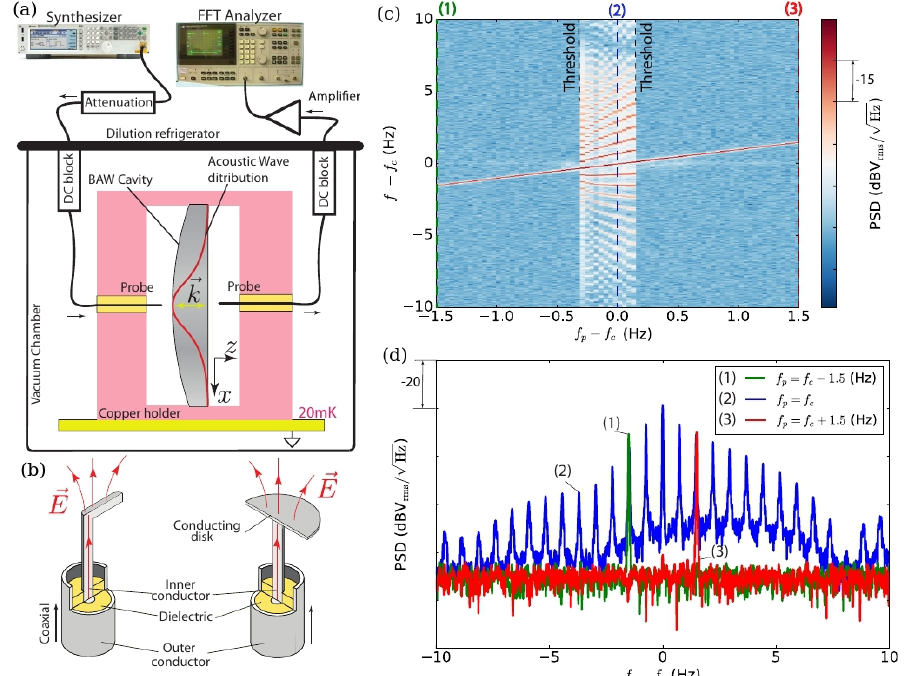
Figure 6. Generation of a BAW-based phononic FC. ( a ) Sketch of the experimental setup showing the BAW resonator, copper holder and excitation probes placed in a vacuum chamber. ( b ) Illustration of two types of excitation probes used in the experiment: L- (left) and disc-shaped (right) antennae. ( c ) A false-colour map composed of the individual output signal PSDs S ( f − f c ) plotted as a function of the pump frequency detuning f p − f c at a constant incident power P = − 66dBm. ( d ) Three PSD curves for different constant incident frequencies f p and the same power P corresponding to slices (1)–(3) along the vertical axis of the plot in panel ( d ). Reproduced from [15] published by the American Physical Society under the terms of the Creative Commons Attribution 4.0 International